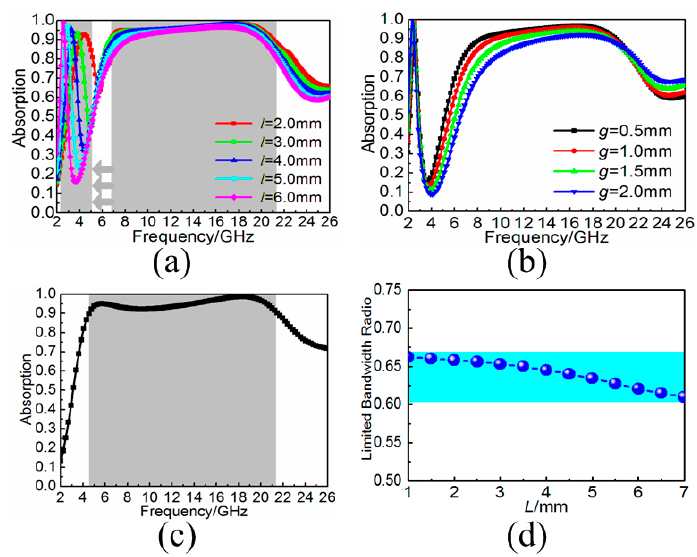
Figure 4. ( a ) Absorption spectra of the three-dimensional resistive MAs loaded with different widths l of metallic bamboo joints; ( b ) absorption spectra of the three-dimensional resistive MAs loaded with different gaps g ; ( c ) absorption spectrum of the three-dimensional resistive MA; and ( d ) limited bandwidth radio of the three-dimensional resistive MAs with different widths l of metallic bamboo joints. Table 1. Calculated absorption bandwidth radio of the three-dimensional resistive MAs loaded with different widths l of metallic bamboo joints.